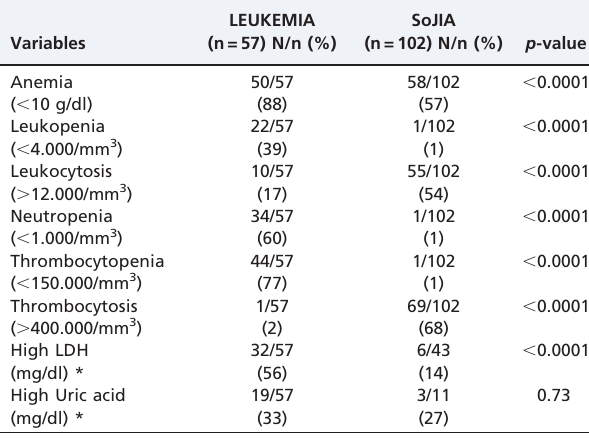
Table 3 - Initial laboratory alterations in acute lymphoblastic leukemia patients vs. systemic-onset juvenile idiopathic arthritis